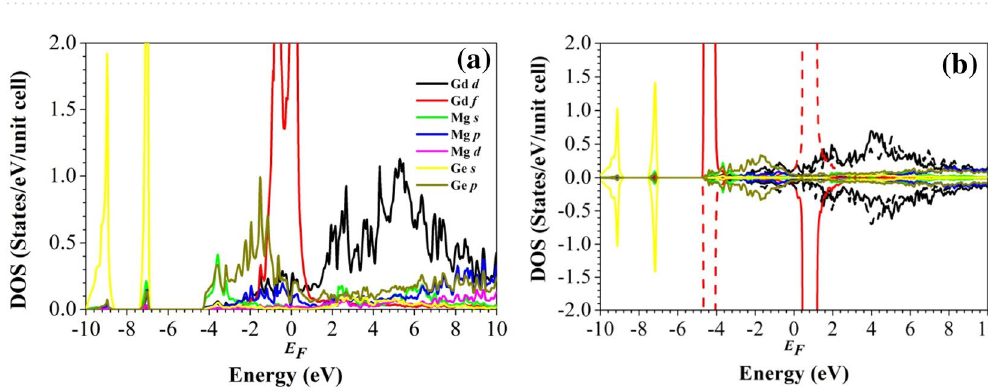
Figure 3. Partial densities of states of Nd 2 MgGe 2 in the ( a ) non-magnetic and ( b ) AF configurations. Full and dashed lines distinguish between the spin sublattices.